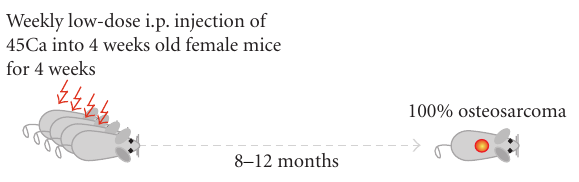
Figure 5: The radiocarcinogenic model . Schematic representation of the radiocarcinogenic osteosarcoma mouse model showing that 4-week old mice weekly receive low-dose injections of 45Ca intraperitoneally (i.p.) for four weeks. Within 8–12 months, all female mice develop osteosarcomas. Most lesions are located in the spines of the animals, and metastases are not frequently